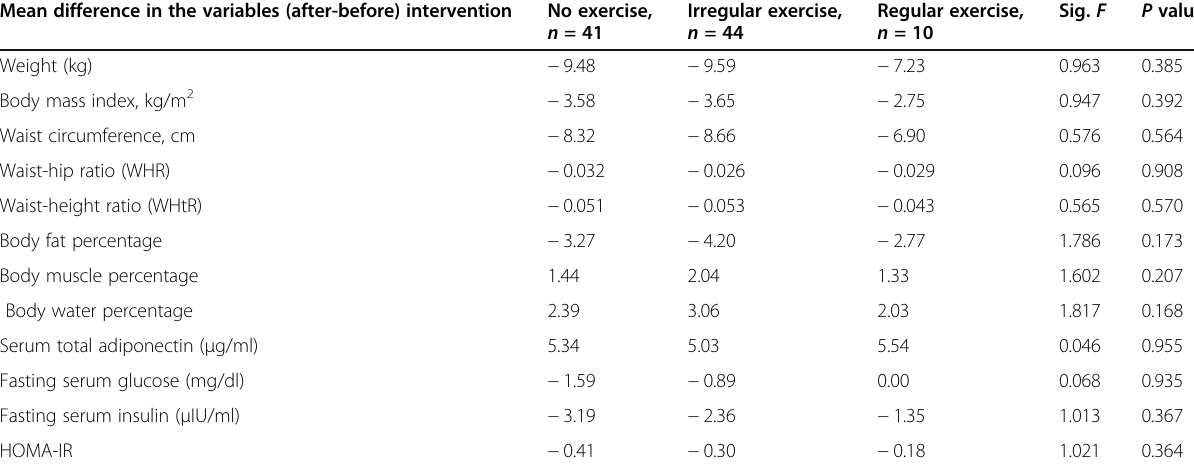
Table 7 Mean difference of anthropometric and laboratory characteristics before and after the intervention according to compliance with physical